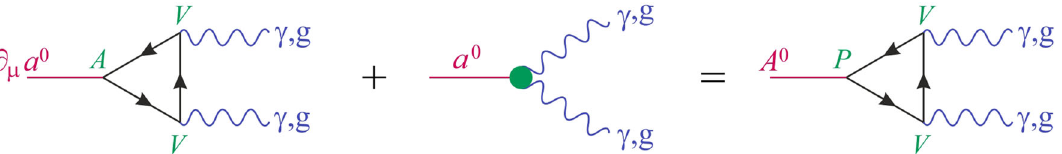
green disk depicts the local anomalous vertex derived from Eq. (56). All the SM fermions but the neutrinos circulate in the γγ loops, while only quarks occur for the gg loops